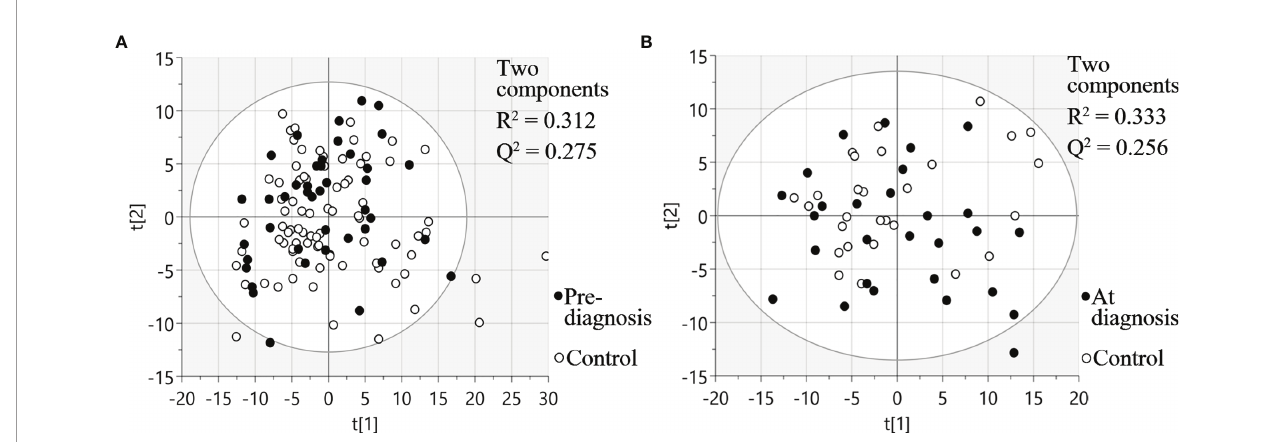
FIGURE 2 | PCA plots visualizing protein expression pro fi les in different samples. (A) Pre-diagnostic plasma samples and matched controls. (B) Diagnostic plasma and controls. t[1] and t[2] are scores of the fi rst two principal